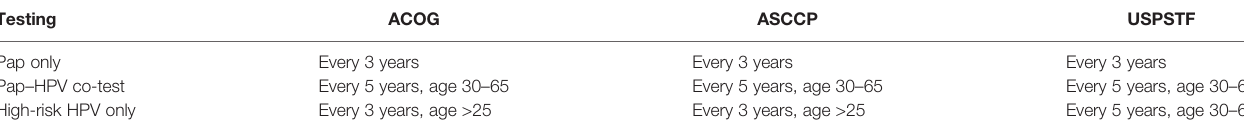
TABLE 5 | Cervical cancer screening recommendations from ACOG, ASCCP, and USPSTF.